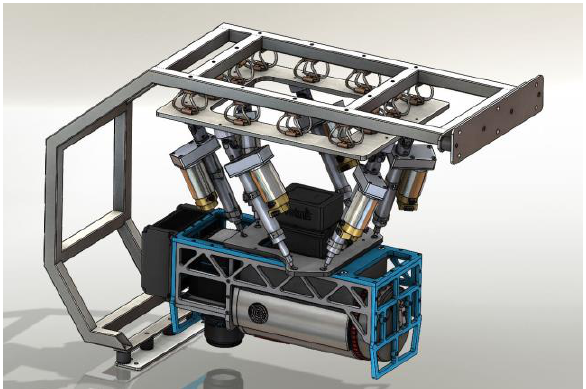
Figure 2. Mapping platform prototype: 3D CAD model.